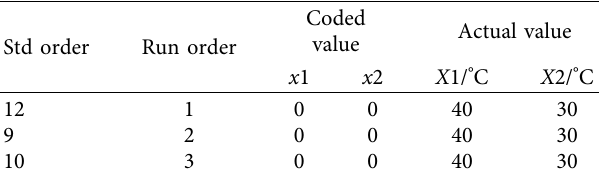
Table 3: CCD experimental program design table (Dutch